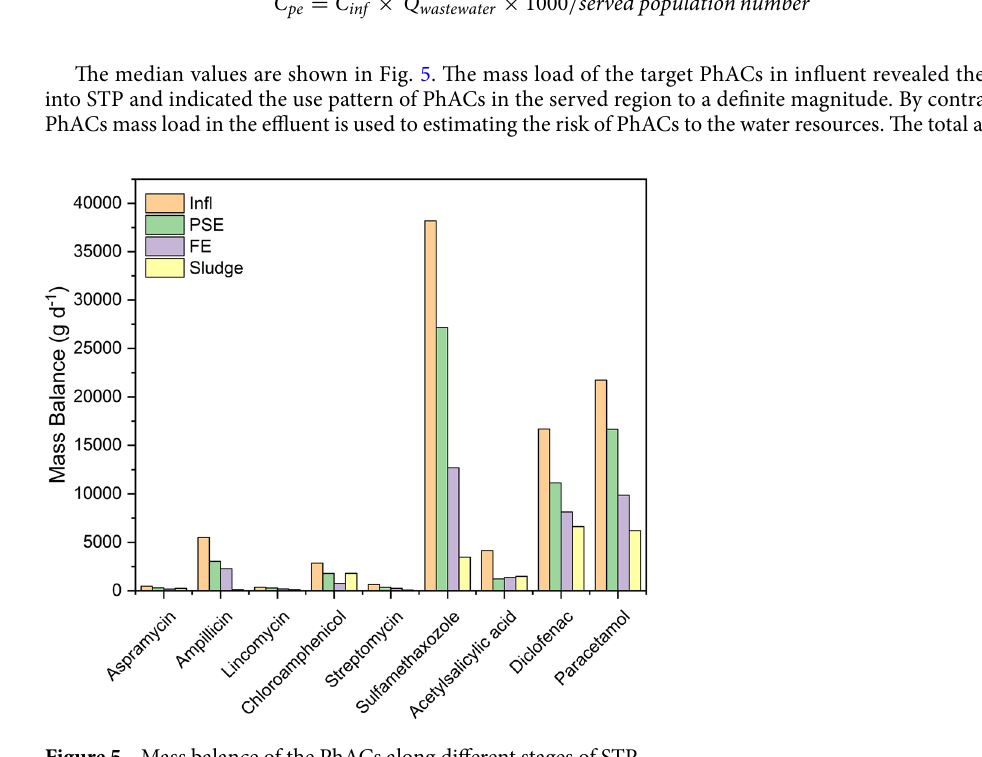
Figure 5. Mass balance of the PhACs along different stages of STP.